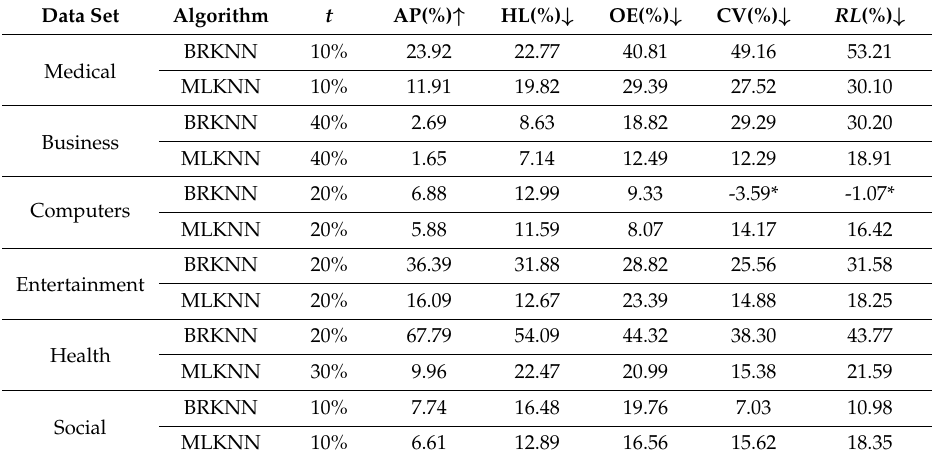
Figure 7. Experimental results on Social data set. ( a ) Average Precision; ( b ) Hamming Loss; ( c ) One Error; ( d ) Coverage; ( e ) Ranking Loss. Table 2. Increase (decrease) percentage of each evaluation metrics on six data